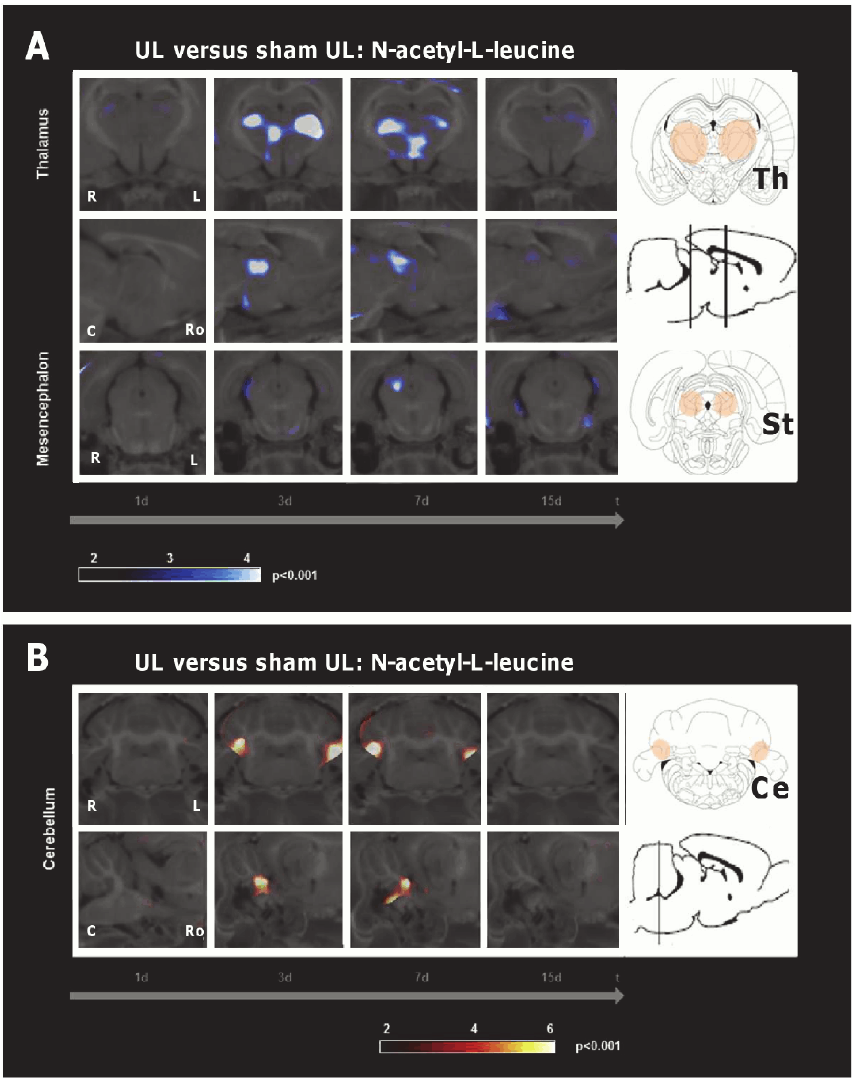
Fig 7. Comparison of the N-acetyl-L-leucine effect on regional cerebral glucose metabolism following unilateral labyrinthectomy and sham unilateral labyrinthectomy. The images depict the comparison of the regional cerebral glucose metabolism (rCGM) on days 1, 3, 7 and 15 between groups treated with N- acetyl-L-leucine (24 mg i.v. per rat) after unilateral labyrinthectomy (UL) and after sham UL (without inner ear damage). A) rCGM was significantly decreased in the posterolateral thalamus bilaterally on days 3 and 7 and the contralesional subthalamic region on day 3 in the UL-group as compared to the sham UL-group. B) On days 3 and 7 rCGM was significantly increased in the vestibulocerebellum bilaterally in the UL-group. R right, L left, C caudal, Ro rostral, Ce cerebellum, St subthalamic region, Th thalamus; p-value <